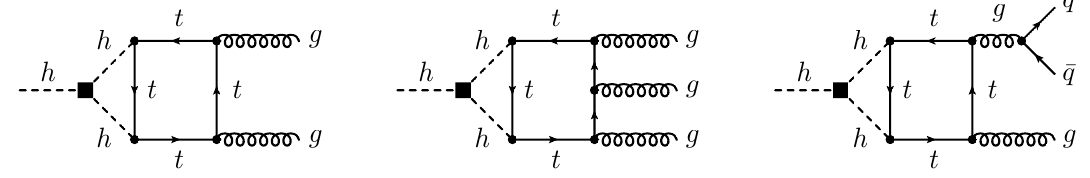
Figure 1 . Examples of two-loop Feynman diagrams with an insertion of an e(cid:11)ective trilinear Higgs coupling (black square) that contribute to the h ! gg (left), h ! ggg (middle) and h ! q (cid:22) qg (right) channel,